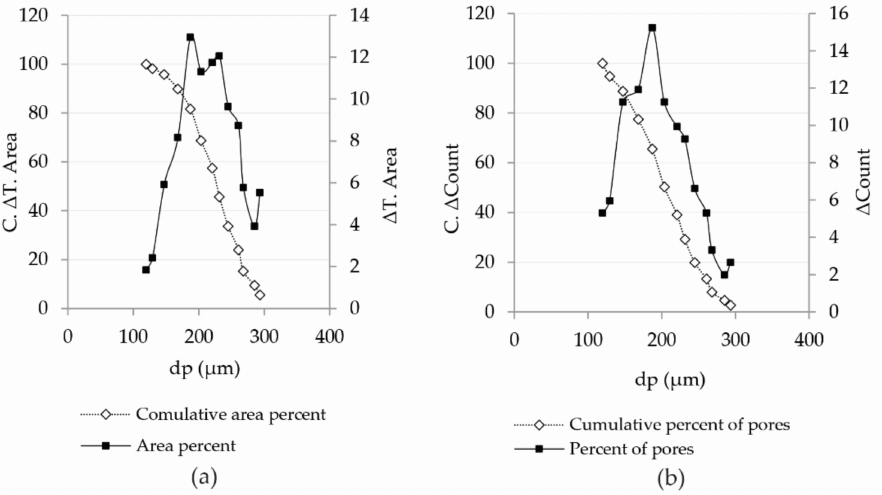
Figure 3. Percentage of area and cumulative percentage of area ( a ) and percentage of pores versus cumulative percentage of pores versus diameter of pores ( b ).